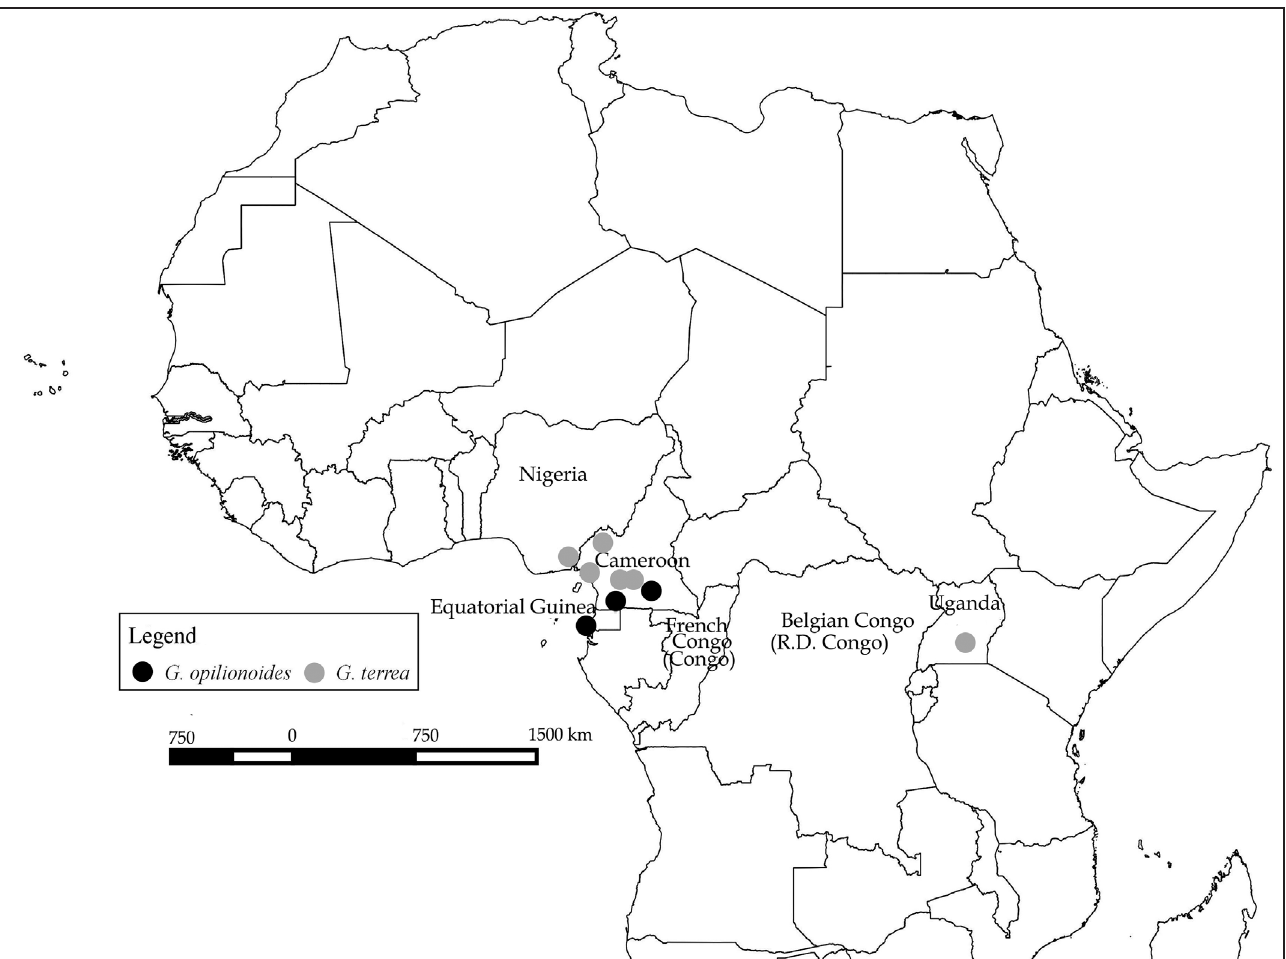
Fig. 1. Distribution map for Gemeneta